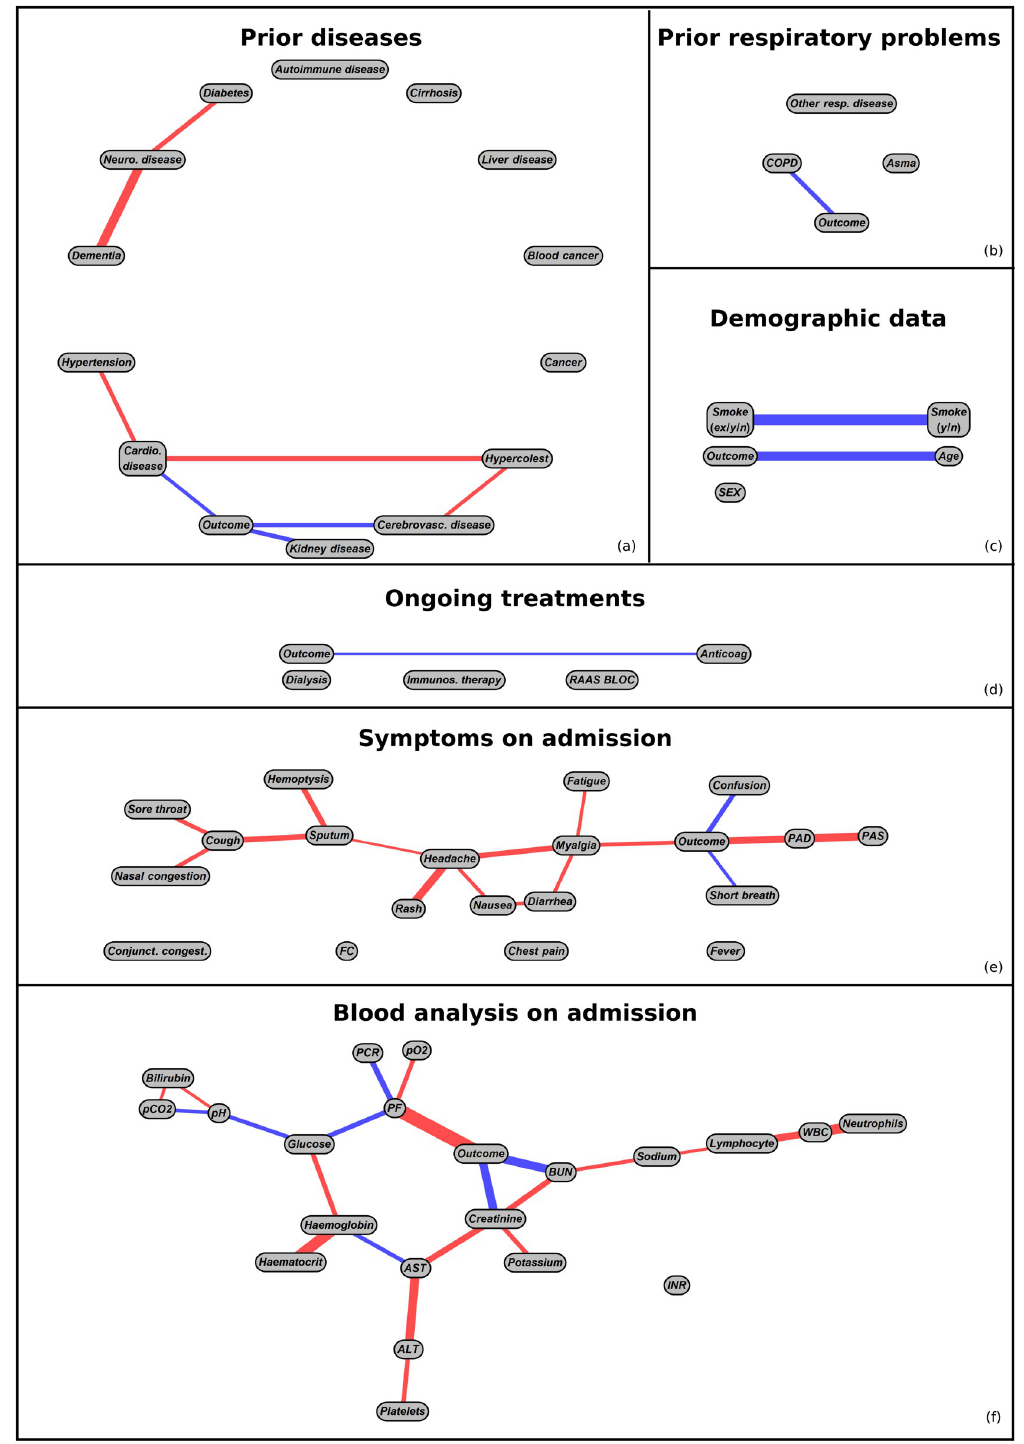
Fig 2. BSL analysis on separate classes of features. Image showing the BSL analysis applied to different categories of features. All the illustrated graphs are generated taking the information provided by clinicians into account.